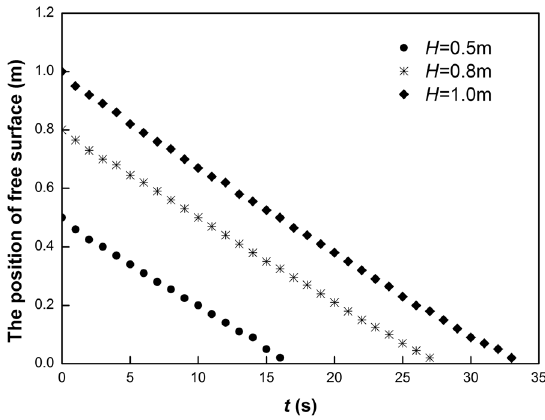
Figure 2. Position of free surface versus time under different heights of sand column ( H